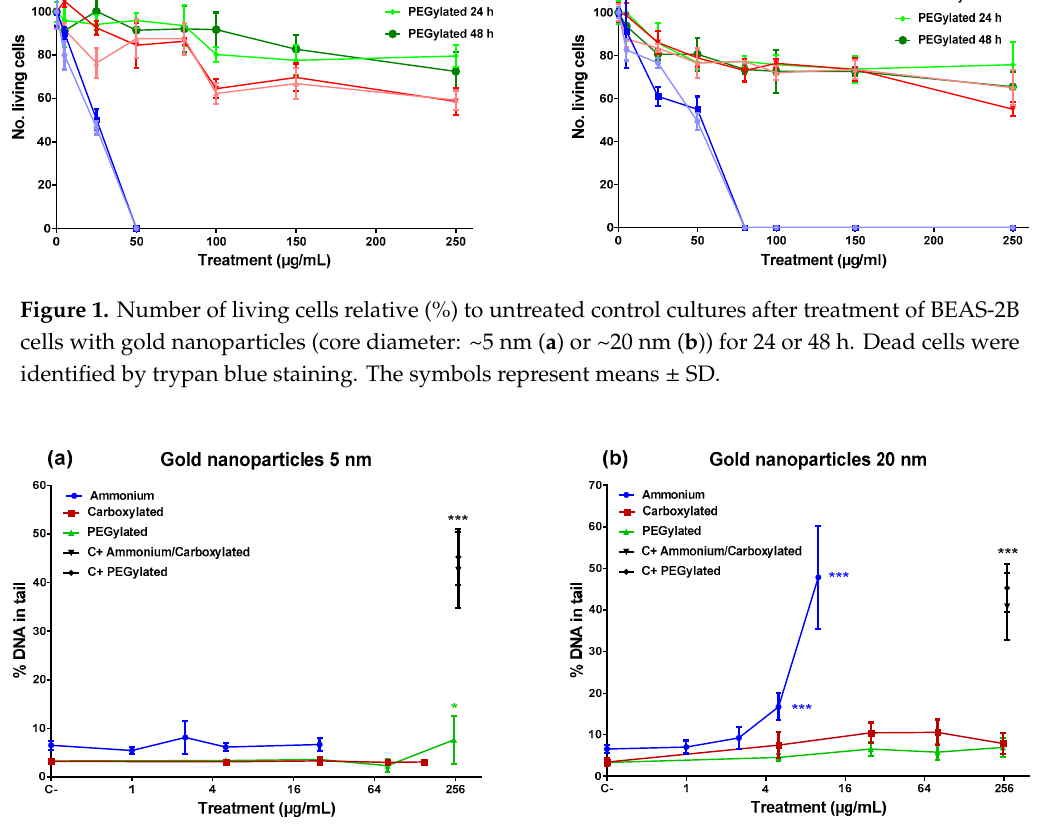
Figure 2. DNA damage expressed as tail intensity (% DNA in tail) in BEAS-2B cells after a 24-h treatment with gold nanoparticles (core diameter: ~5 nm ( a ) or ~20 nm ( b )). Treatment is expressed as the antilog of Log 2 of the dose. Here, 100 µM H 2 O 2 was used as a positive control (C+; symbols on the right show results from the experiments carried out). The symbols represent means ± SD. Statistical significance in comparison with control cultures (one-way ANOVA): * p < 0.05; *** p <